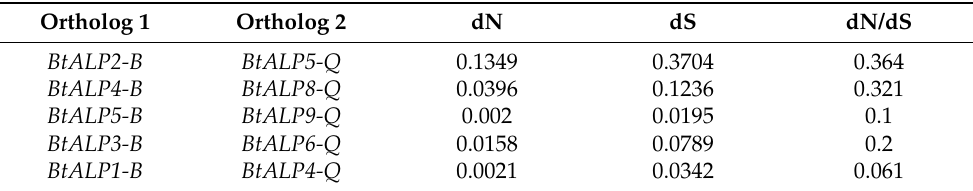
Table 3. The dN/dS ratio of ALP orthologs in